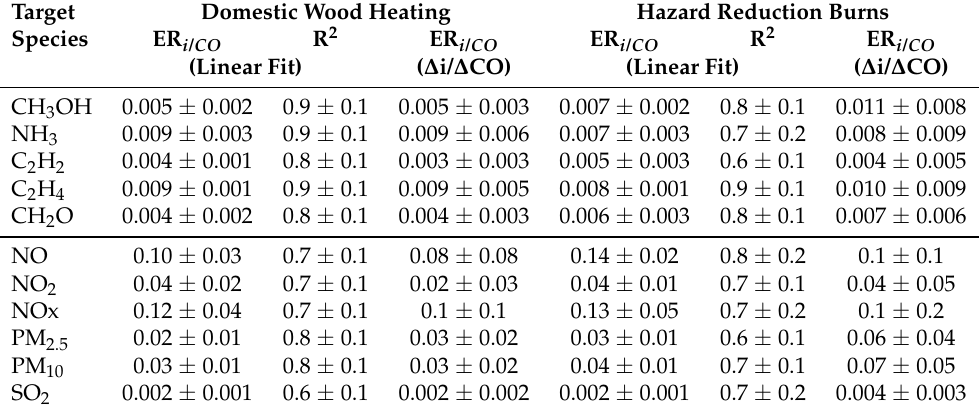
Table A2. Enhancement ratios of trace gases and particulate matter against CO retrieved from domestic wood heating and hazard reduction burn smoke periods. Those enhancement ratios were retrieved from a selected 16 domestic wood heating and 5 hazard reduction burns events through the Linear Regression method, as well as from all 42 domestic wood heating and 5 hazard reduction burn events using the Ratio of Averages